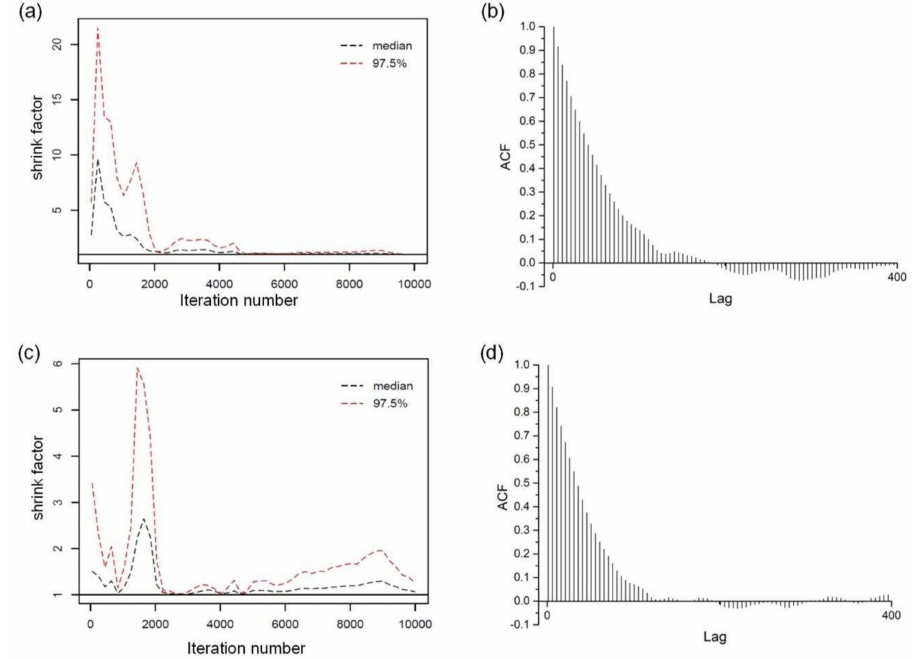
Figure 11. Shrink factor of ( a ) cable force and ( c ) flexural rigidity; with ACF of ( b ) cable force and ( d ) flexural rigidity in the last 5000